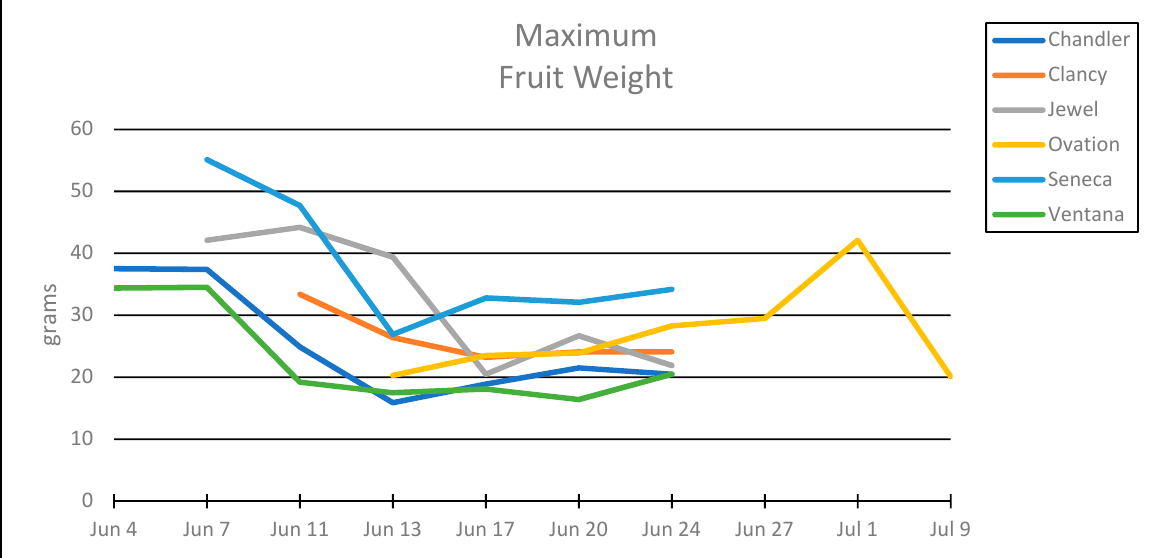
Figure 7. Maximum fruit weight for six short-day strawberry varieties grown in plasticulture in a cold climate region (central NY) in Trial 2 harvested in 2014. High maximum fruit weights were maintained throughout the harvest. Mean fruit weight is reduced as fewer large fruit are harvested.